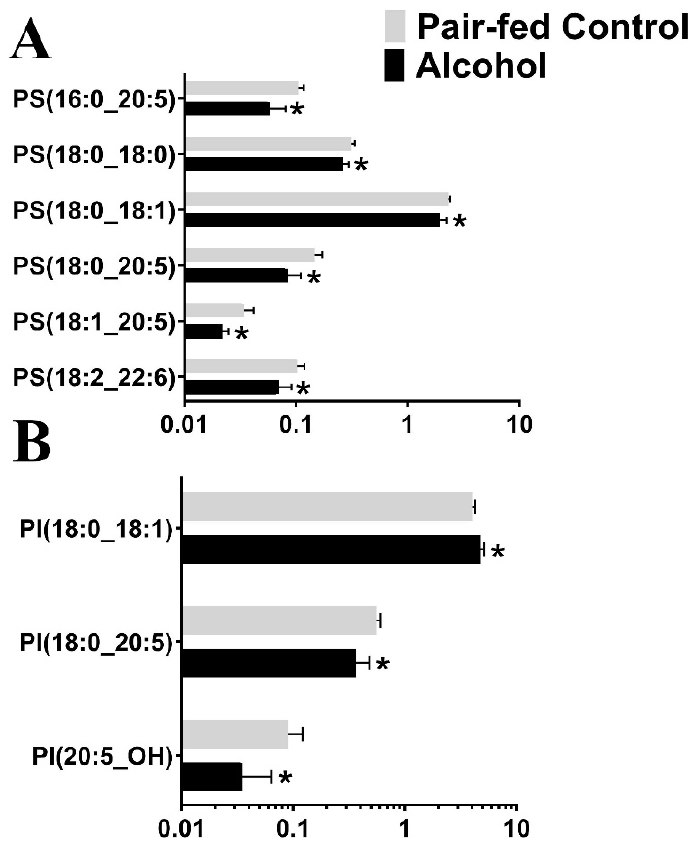
Figure 5. Significantly altered ( p < 0.05) Phosphatidylserine and Phosphatidylinositol subspecies in the maternal blood following gestational alcohol exposure. ( A ) Targeted analysis of phosphatidylserine (PS) and ( B ) Phosphatidylinositol (PI) was performed to identify of PS and PI levels in rat maternal blood following alcohol consumption during pregnancy. *, p < 0.05. Table 3. Species of lipids and their corresponding lipid subspecies number, which was signi fi cantly altered by alcohol following targeted lipidomic analysis.